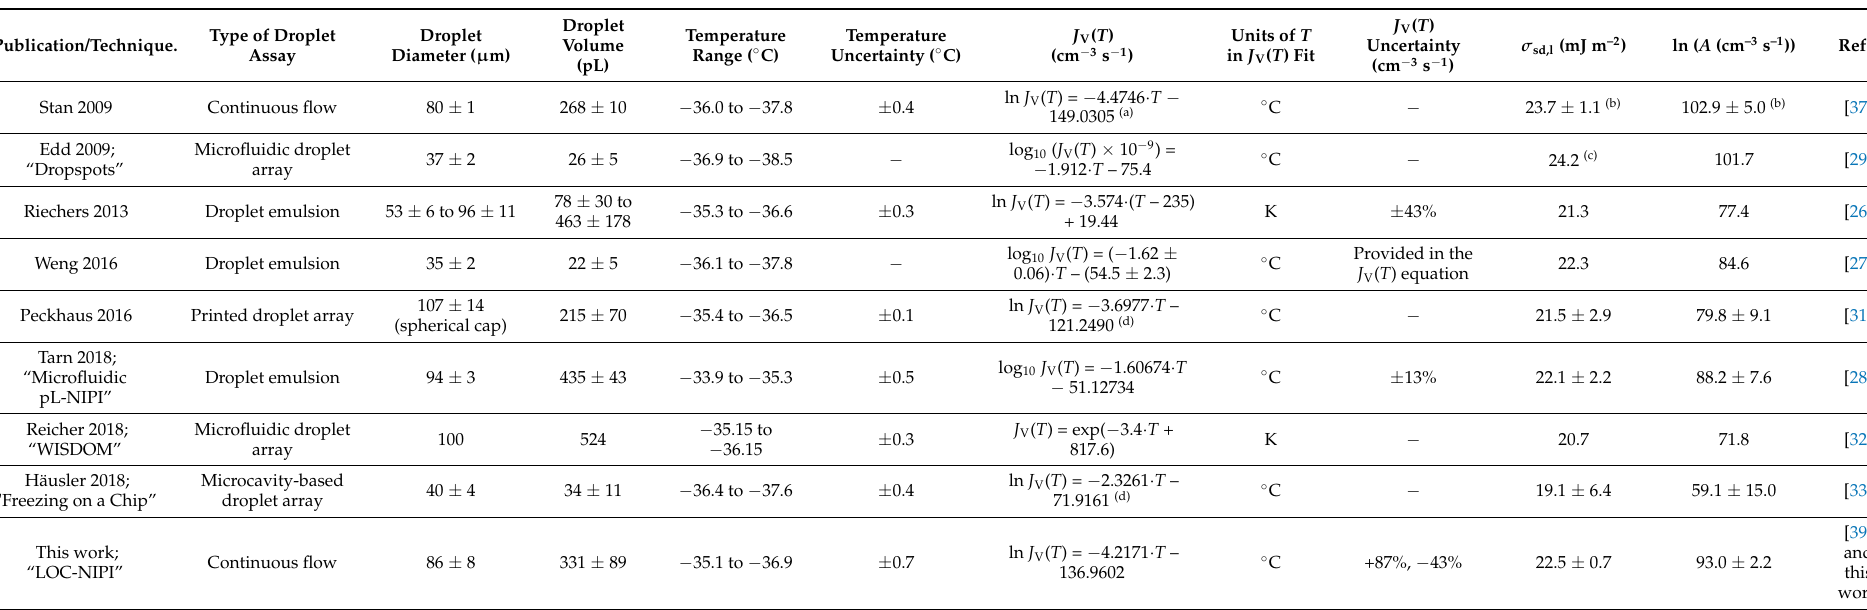
which hexagonal ice (ice I h ) is considered to be the nucleating phase. (d) J V ( T ) determined by fitting to digitised data of the coldest, steepest part of the purified water f ice ( T )